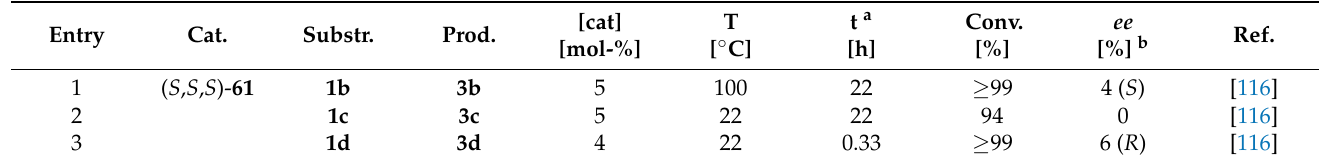
Table 16. Catalytic asymmetric intermolecular hydroamination of aminoalkenes 1b – d using the